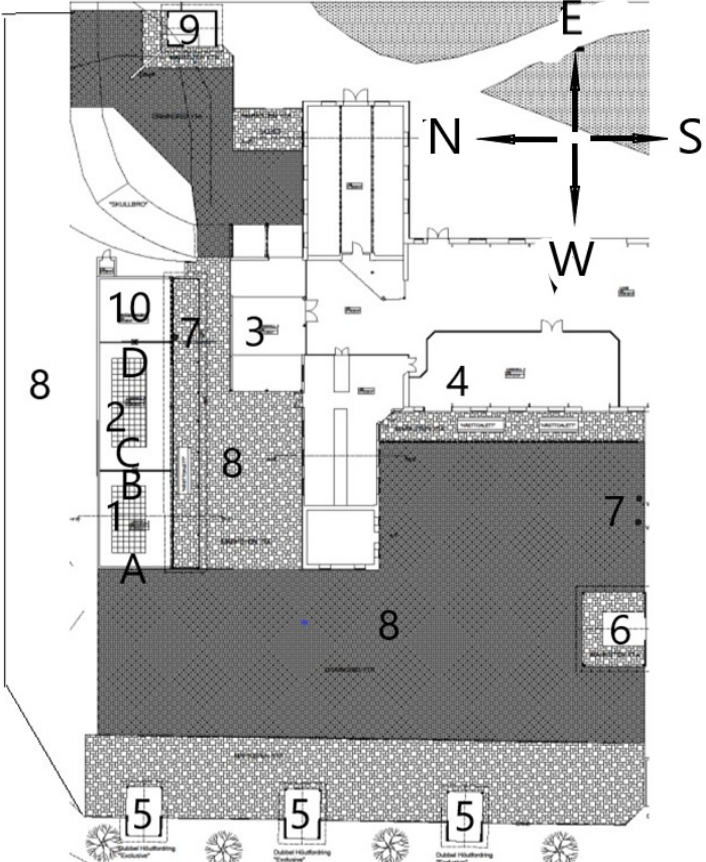
Figure 3. Detailed layout of the open barn. 1: Lying hall 1 (80 m 2 , used in period 2 and 3), 2: Lying hall 2 (100 m 2 , used in period 3), 3: Lying hall 3 (100 m 2 , not in use during experimental study),